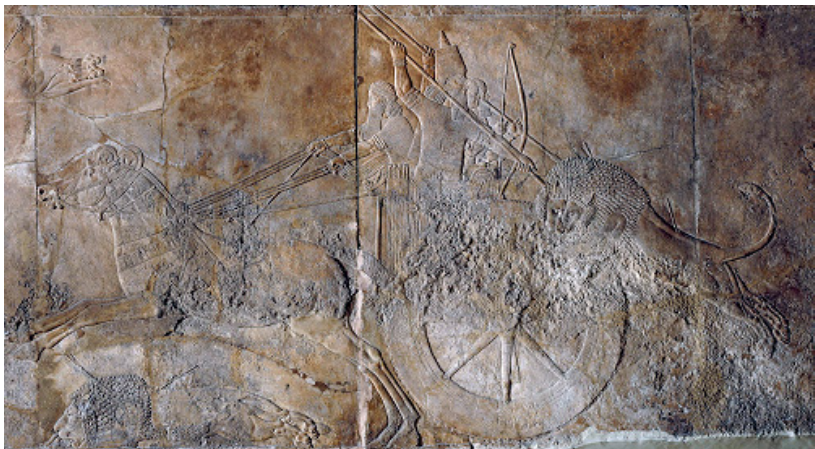
Figure 3. King Ashurbanipal hunting lions (BM inv. nos. 124850–51; reg. no. 1856,0909.15); relief scene (panels 20–21), gypsum; N Palace (Room C), Nineveh (mod. Iraq); Neo-Assyrian, ca. 645–635 BCE [image courtesy of the Trustees of the British Museum, London].